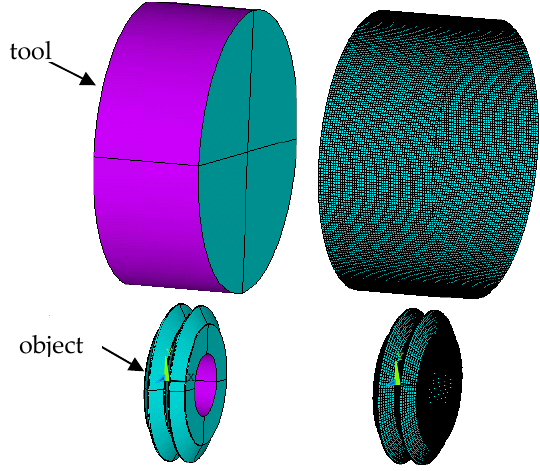
Figure 8. Geometry of the object, tool, and finite element mesh.